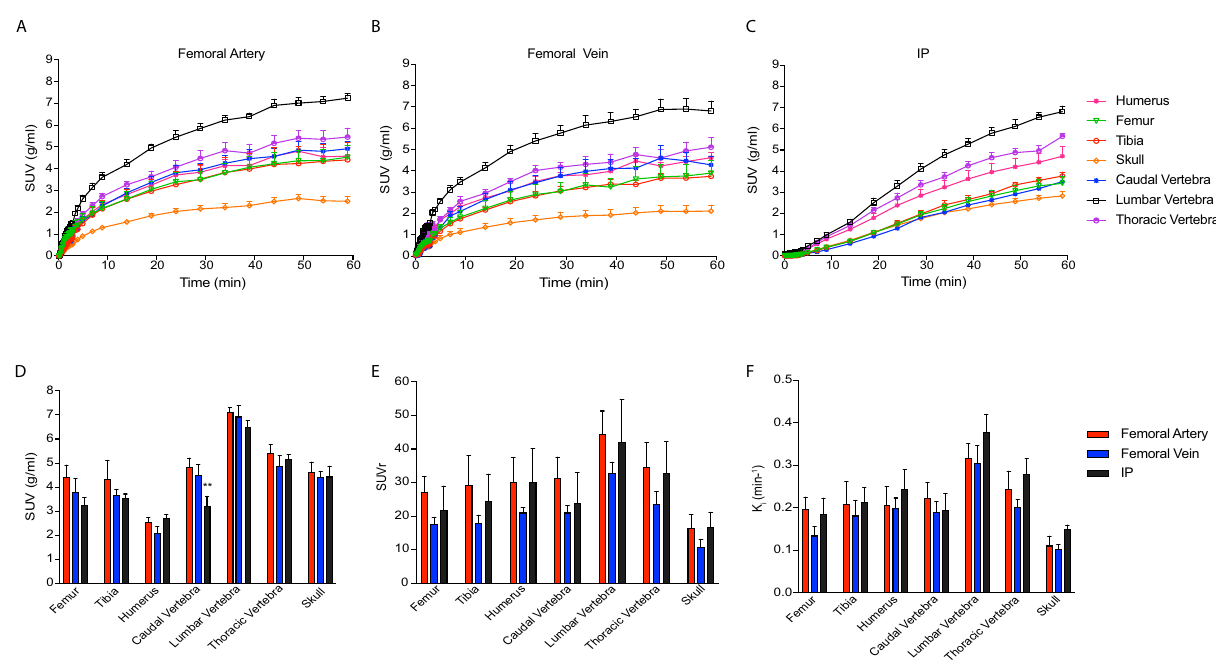
Figure 2. Bone mean time activity curves after femoral artery ( A ), femoral vein ( B ) and IP injection ( C ) of 18 F-NaF. Error bars represent one SEM. Mean standardised uptake value; SUV ( D ), standardised uptake value ratio relative to blood pool; SUVr ( E ) and influx constant; K i ( F ) of several bones after femoral artery, femoral vein and intraperitoneal (IP) 18 F-NaF administration. Error bars represent one SEM. 2-way ANOVA with multiple comparisons and Tukey’s post-hoc test was used to calculate P values. (** P = 0.0087 femoral artery vs IP administration